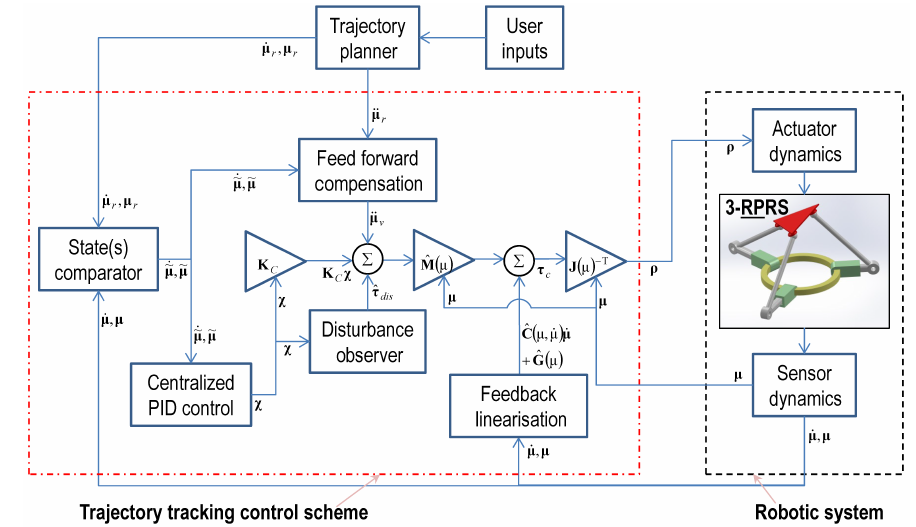
Figure 3. Block diagram representation of the proposed robust task-space control scheme.